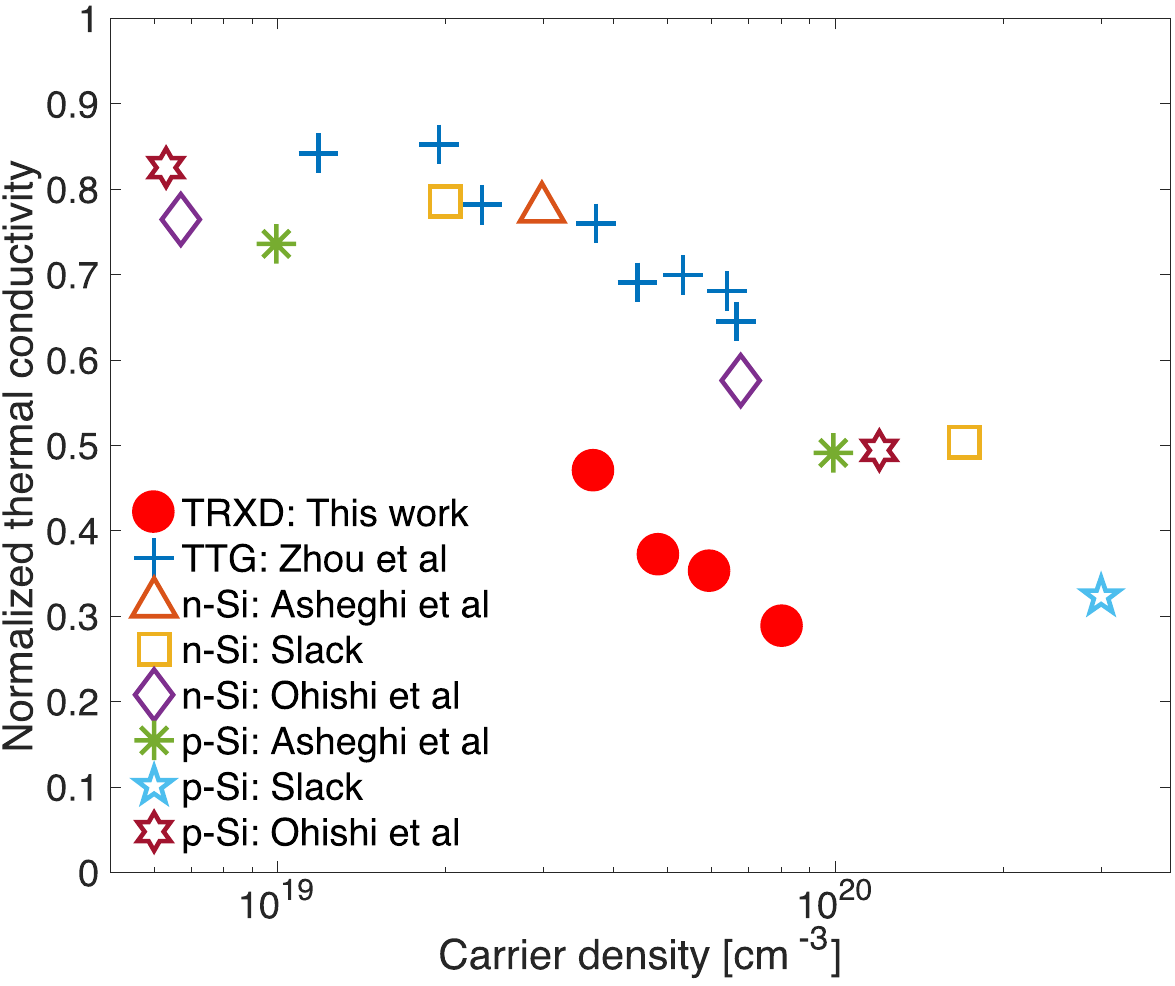
Figure 5. Measured thermal conductivity normalized to the bulk value as a function of carrier density. The carrier density in this work was estimated from mean surface carrier density within the X-ray extinction depth at ∆ t = 0. The results from previous research using different measurement techniques (e.g., the transient thermal grating measurement [9] and doped Si [51–53]) are also